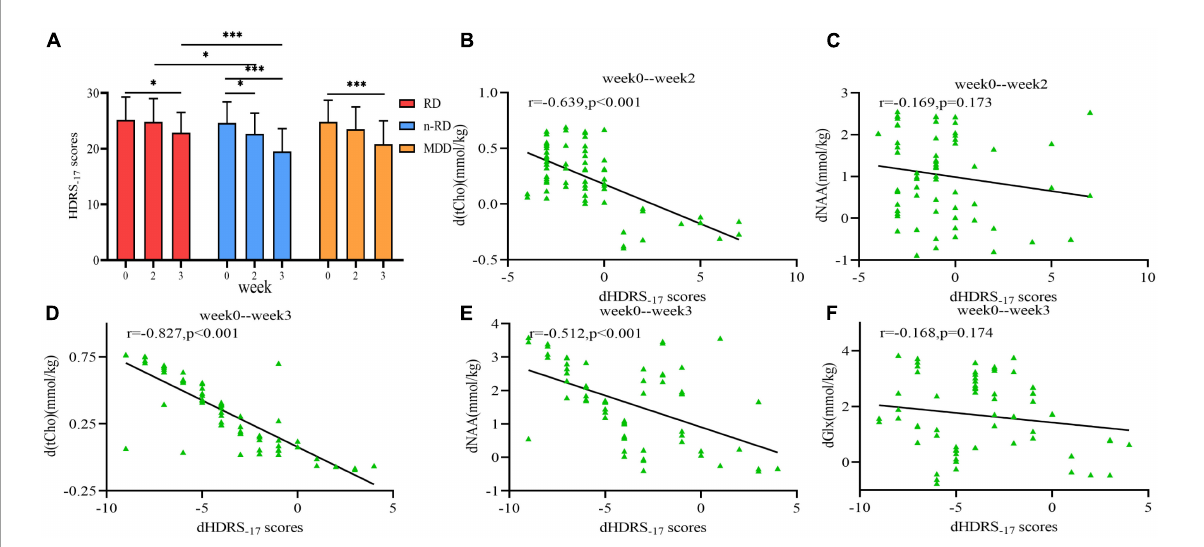
FIGURE5 (A) The within-group and between-group comparisons of Hamilton Rating Scale scores change in refractory depression group, non-refractory depression group and major depression disorder group show significant differences. (B–F) Scatter plots depict the relationship between metabolites changes (d(tCho), dNAA and dGlx) in hippocampus and the clinical treatment response (dHDRS) after 2 and 3 weeks. HDRS-17, Hamilton Rating Scale 17-item for depression; NAA, N-acetyl-aspartate; tCho, phosphocholine and glycerophosphocholine; Glx, glutamate and